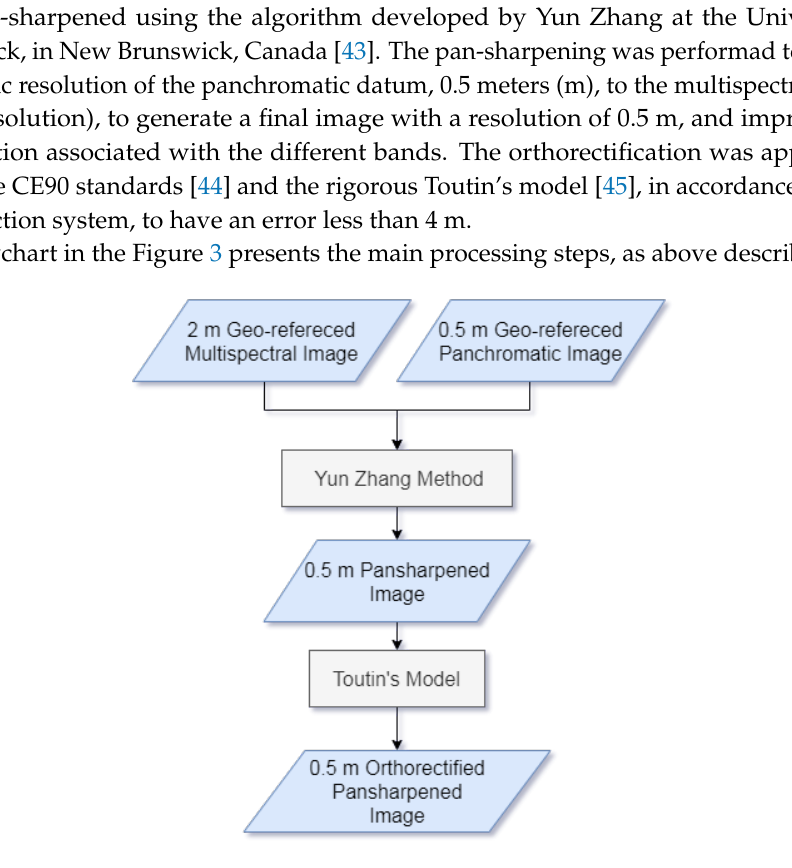
Figure 3. Flowchart for WorldView-2 image